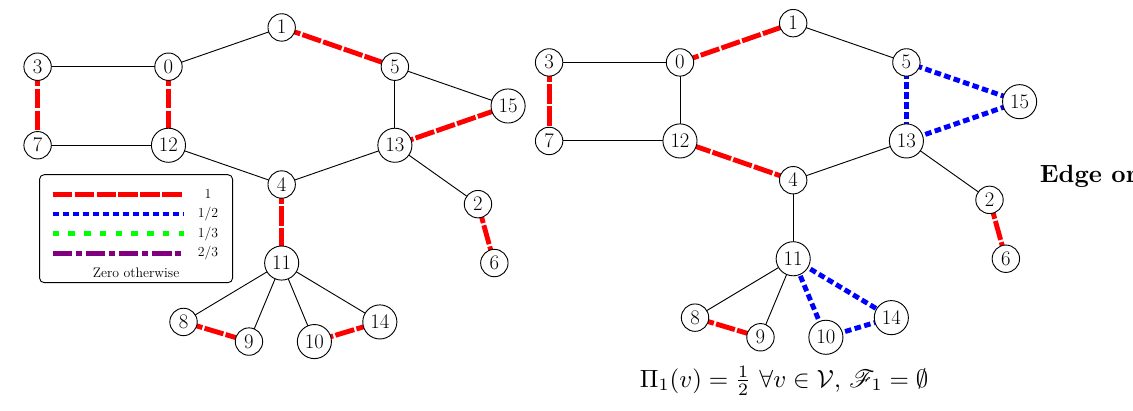
Figure 1 Lexicographically-minimal Perfect Matching